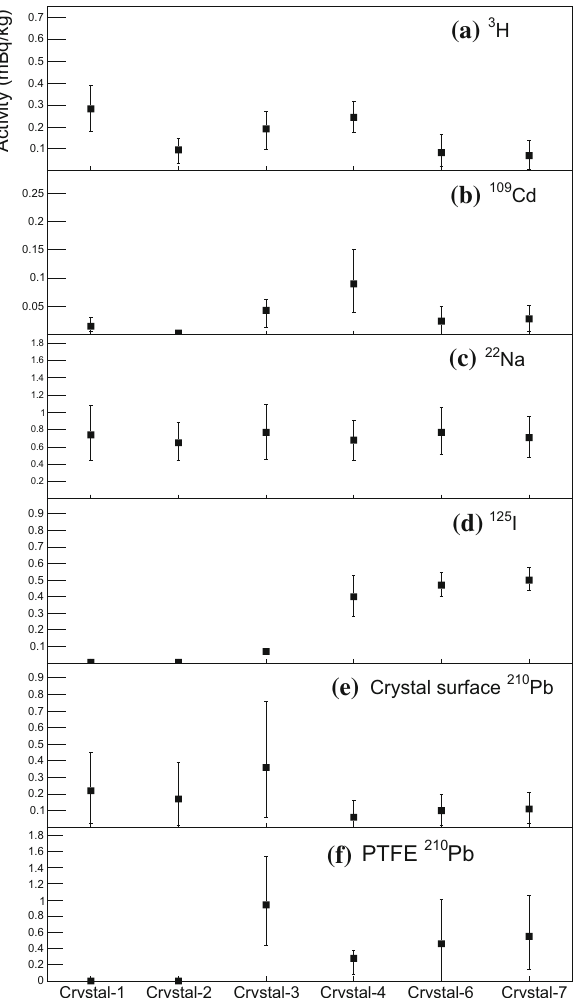
Fig. 8 Fitted activities for a 3 H, b 109 Cd, c 22 Na, d 125 I, e Crystal sur- face 210 Pb, and f PTFE 210 Pb that correspond to the averaged activities between Oct 21 and Dec 19 2016. Activities of crystal surface 210 Pb and PTFE 210 Pb were normalized by a total mass of the